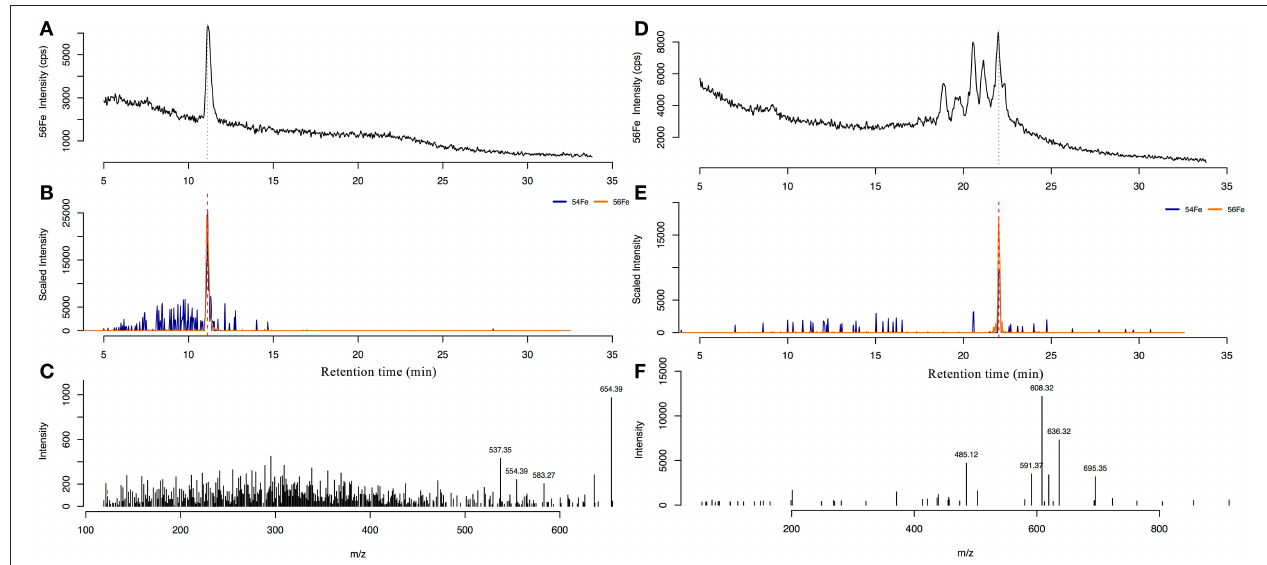
FIGURE 3 | The 56 Fe ICP-MS spectra (top) of ferrioxamine E (A) in the 15m sample, and amphibactin H in the 300m sample (D) . (B,E) shows the extracted ion chromatogram (EIC) of the 54 Fe and 56 Fe isotope peaks of ferrioxamine E and amphibactin H, respectively. Bottom panels show the MS 2 fragmentation spectra from the compound at the corresponding retention time for ferrioxamine E (C) and amphibactin H (F) . TABLE 3 | Siderophore and total iron binding ligand parameters determined at Station ALOHA. Depth